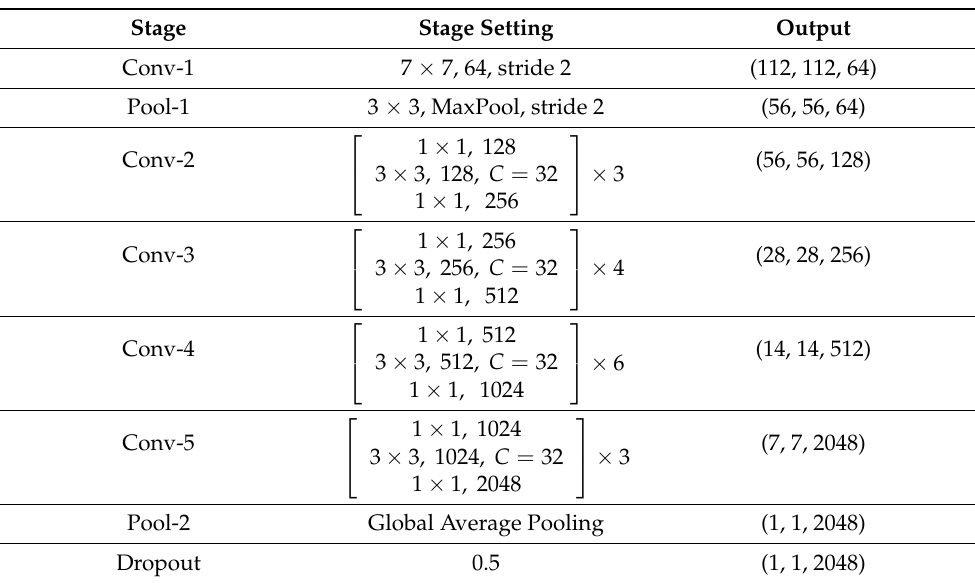
Table 1. Structure of